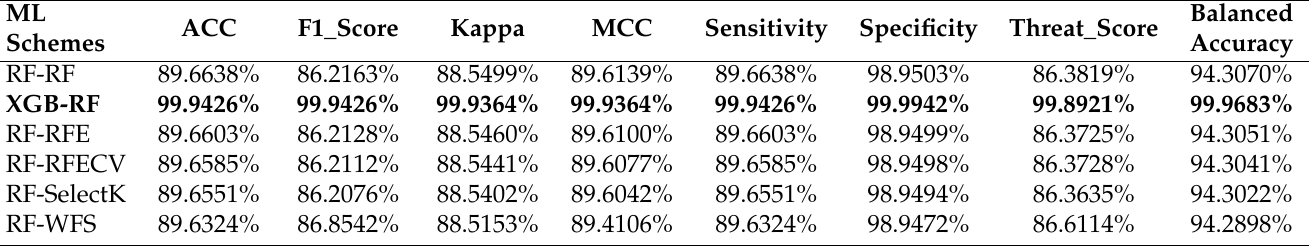
Table 3. Performance of Classification